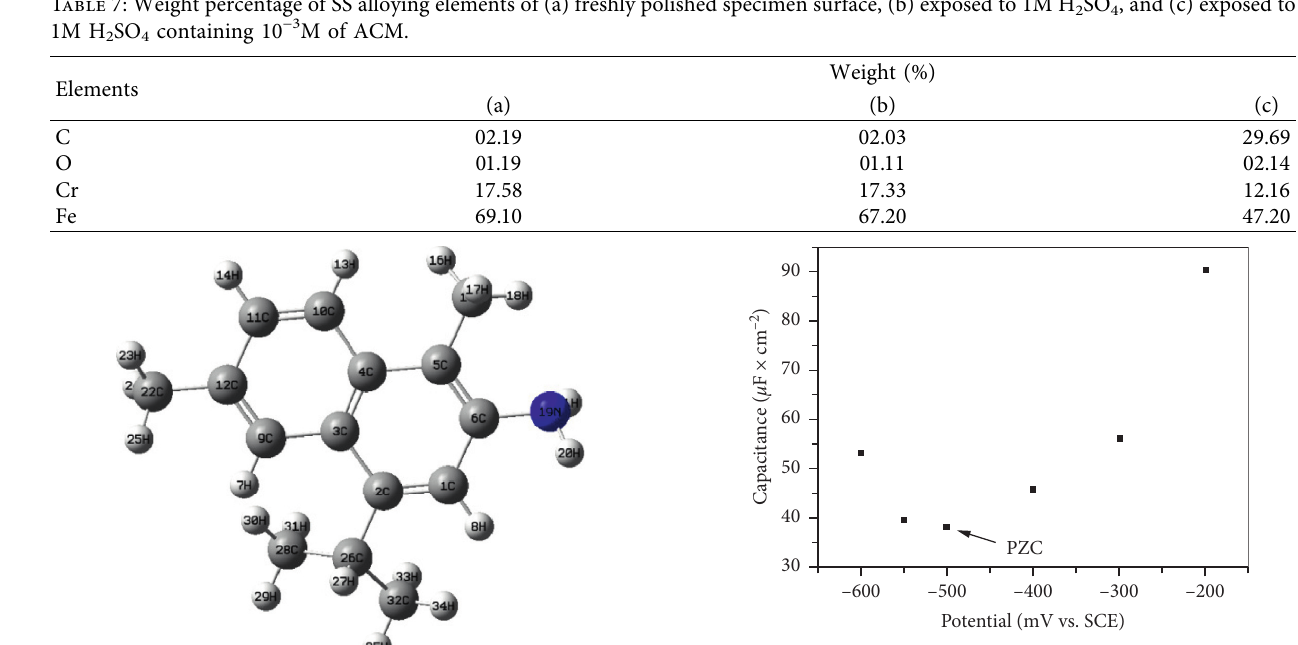
Figure 9: Plot of capacitance against the applied potential for SS